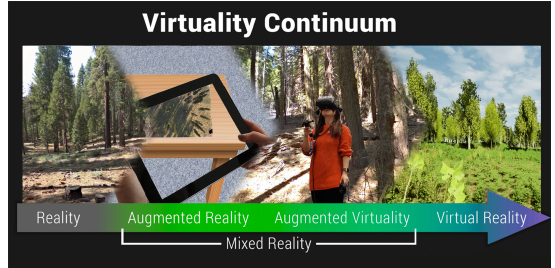
Figure 1. The virtuality continuum first suggested by (Milgram and Kishino, 1994). It starts on the left with physical reality and arrives at a completely digital world on the right termed virtual reality. In between we find the realm of mixed reality that can have several sub-concepts, here augmented reality and augmented virtuality. The difference is that in augmented reality digital content is superimposed onto the physical world, while augmented virtuality refers to replications of the physical world in a virtual reality setting (modified from (Klippel,